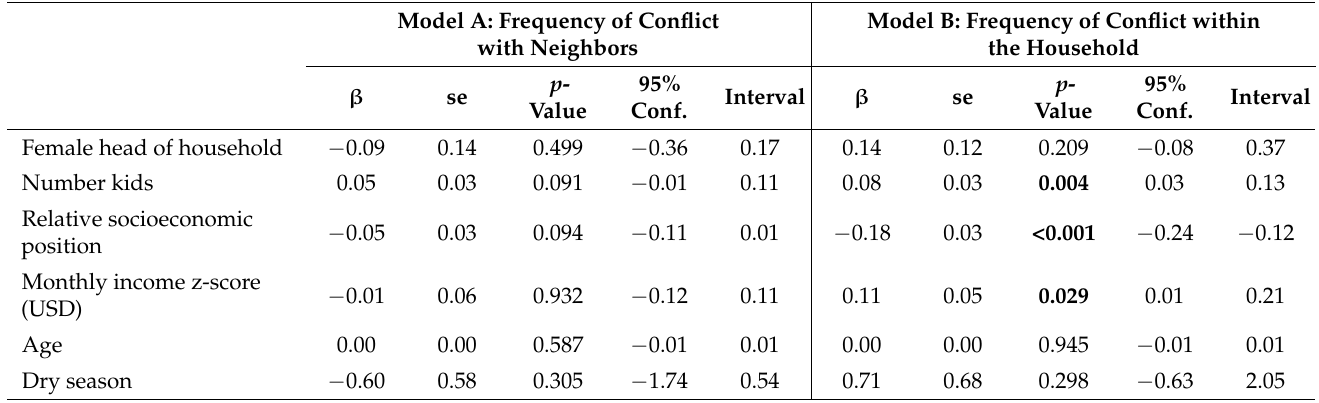
Table 4. Ordinal logistic regression modeling results for associations between demographic characteristics and conflict with neighbors (Model A) or within the household (Model B). Model A: Frequency of Conflict Model B: Frequency of Conflict with Neighbors